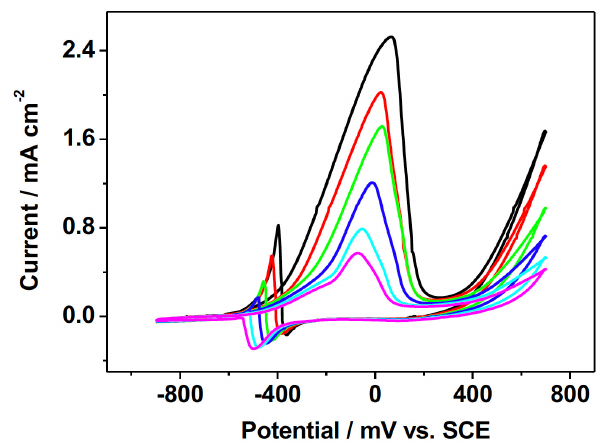
Figure 4. Temperature dependence studies for Pd NPs on gold for methanol oxidation